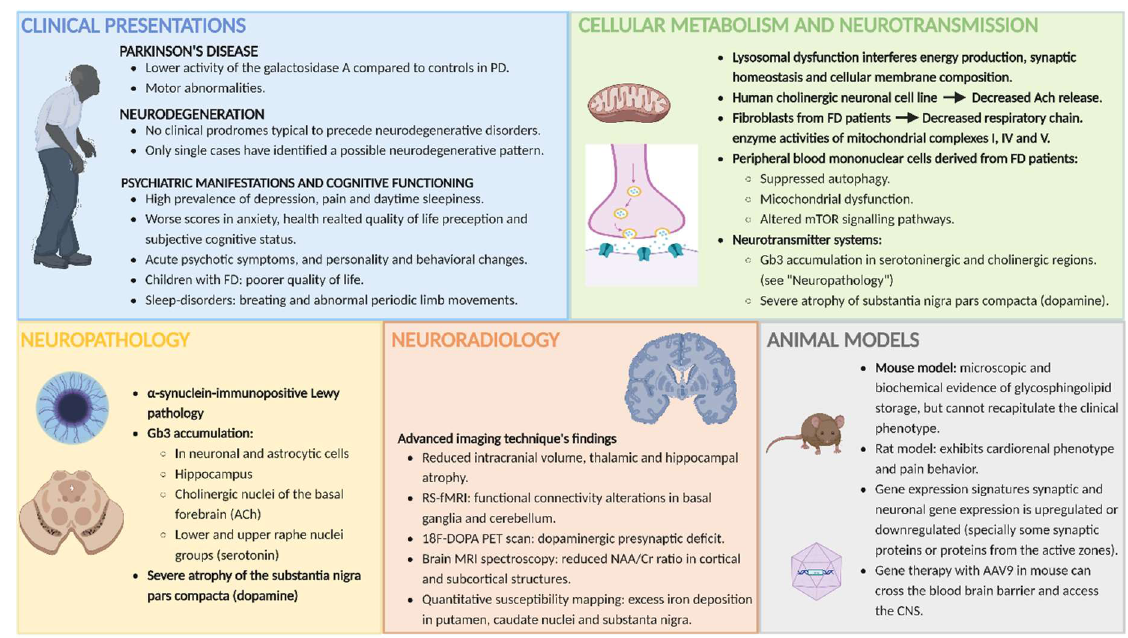
Figure 1. Graphical summary of the central nervous system implications in Fabry disease. This figure summarizes the main findings that will be highlighted and discussed in this review. It focuses on the central nervous system implications in Fabry disease that go beyond the classical involvement of the peripheral nervous system and cerebrovascular disease. The picture addresses the different points of view on FD and its clinical implications, as well as its radiological and neuropathological findings, and cellular, metabolic and synaptic implications (follow main text for details in the next sections). Abbreviations: AAV9 = adeno-associated Virus 9; ACh = acetylcholine; FD = Fabry disease; Gb3 = globotriaosylceramide; mTOR = mechanistic target of rapamycin; NAA/Cr ratio = N-acethyl aspartate/creatine ratio; PD = Parkinson’s disease; PET = positron emission tomography; RS-fMRI = resting-state functional magnetic resonance imaging.